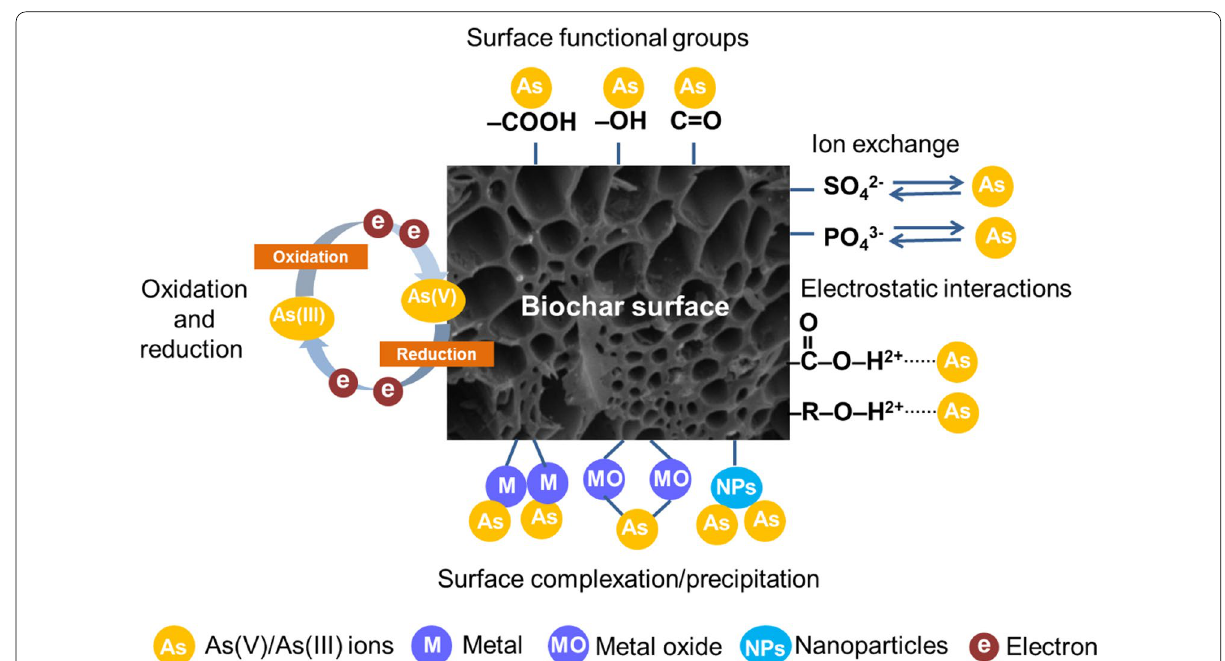
Fig. 3 Principal adsorption mechanisms of arsenic from water by pristine and modified